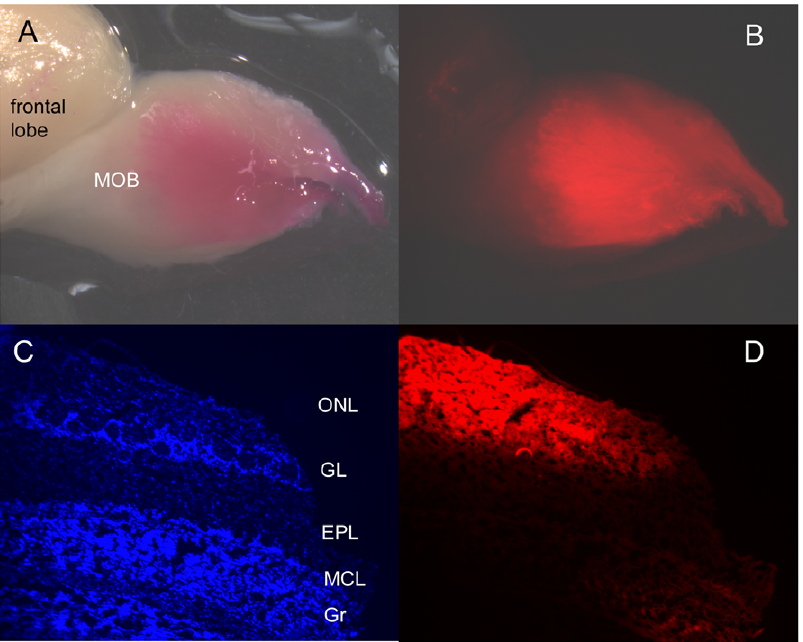
Figure 3. Histological evaluation of the extent of the olfactory nerve block. DiI was applied to the cut ends of the exposed olfactory nerve. (A) shows a whole mount, bright field view of the main olfactory bulb. (B) shows the same view as A under fluorescence. (C) shows a section through the olfactory bulb showing the cell bodies with DAPI staining; the olfactory nerve layer (ONL), the glomerular (GL), external plexiform (EPL) and mitral cell (MCL) and granule cell (Gr) layers of the bulb are indicated. (D) shows the DiI staining in the same section.